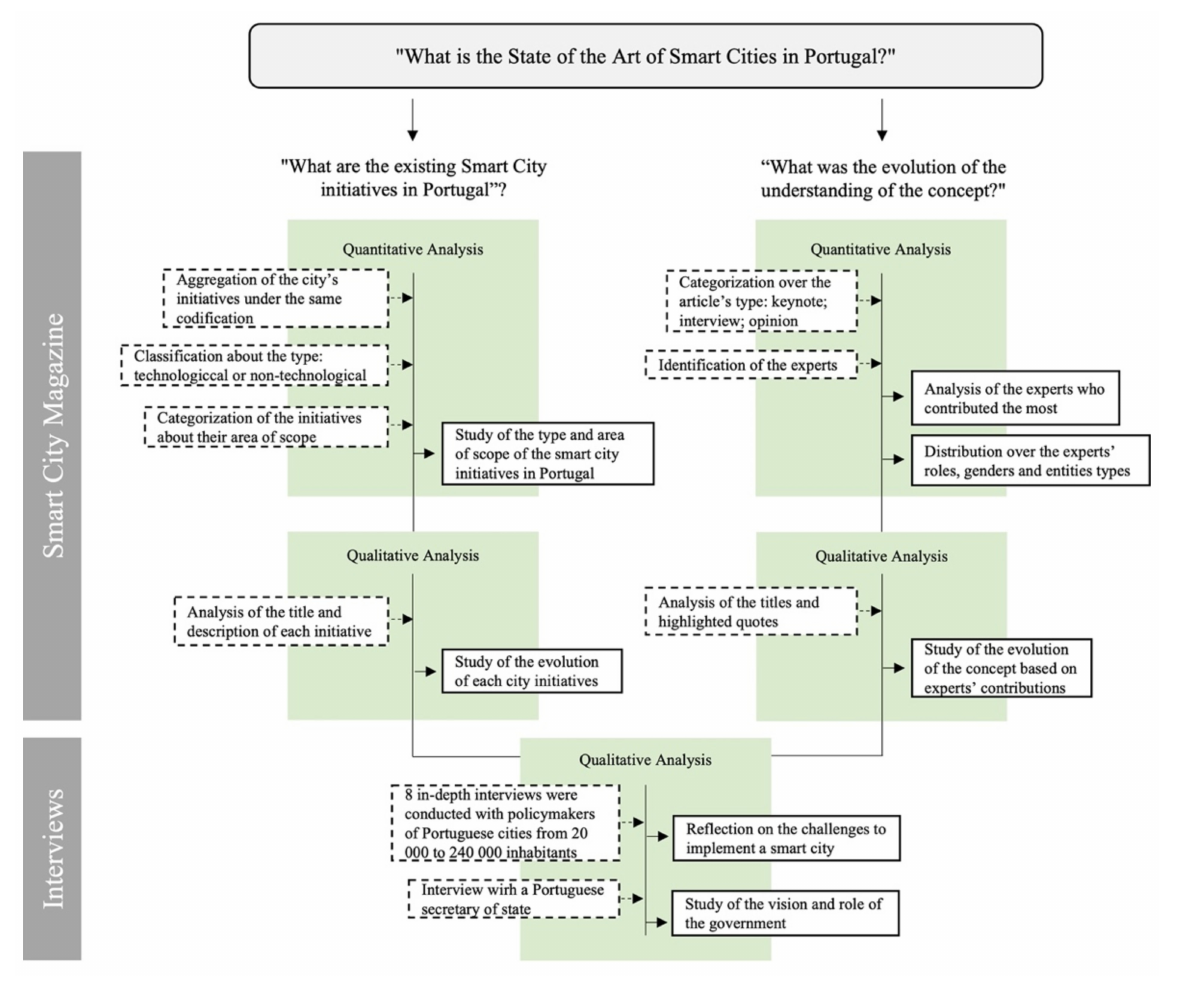
Figure 1. Methodology